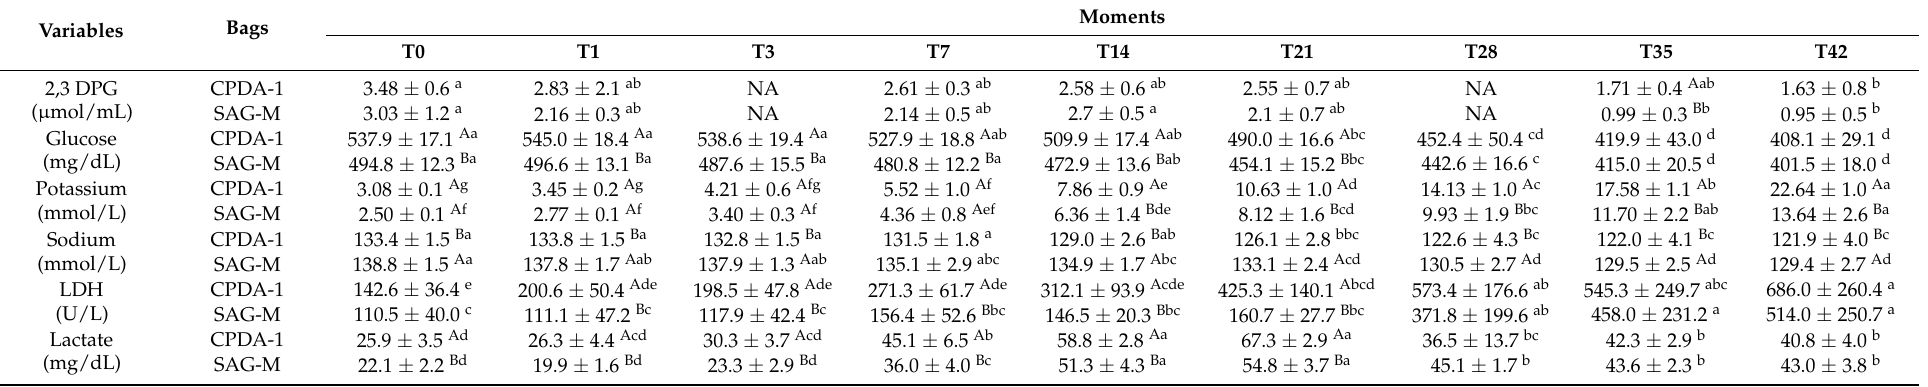
Table 3. Mean and standard deviation values of biochemical variables of donkey whole blood stored in CPDA-1 and CPD/SAG-M bags for 42 days.